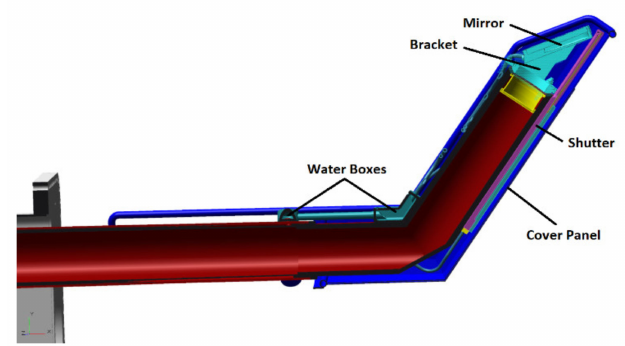
Figure 3. Front of the